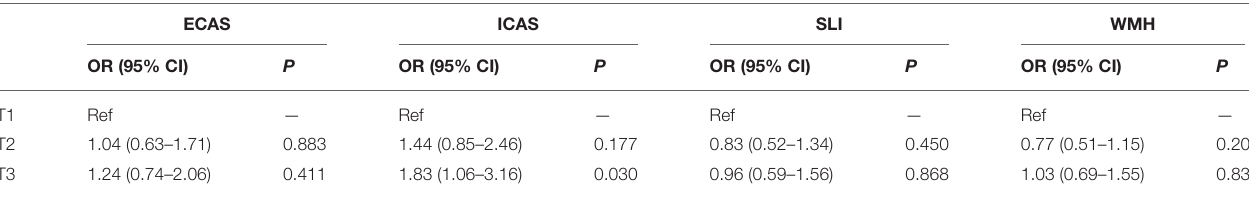
TABLE 2 | Logistic regression analysis of ECAS, ICAS, SLI, and WMH based on THR tertiles.